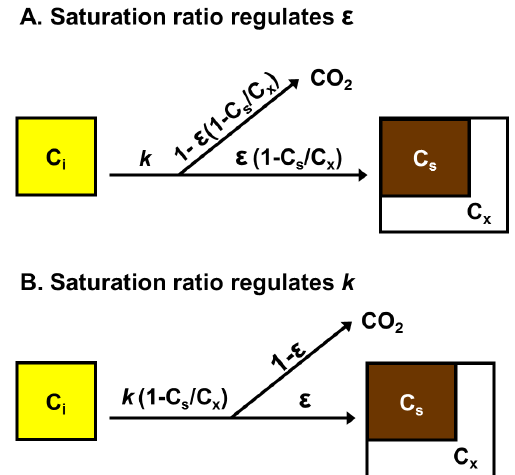
Figure 1. Conceptual models illustrating two different methods of implementing C saturation dynamics. In both models, the C satura- tion ratio of the saturating pool is defined by the ratio of the current pool size (C s ) to a theoretical maximum pool size (C x ) , or C s /C x . In model A, the C saturation ratio regulates the C transfer efficiency ( ε) between the donor pool (C i ) and C s . As the C saturation ratio increases, less of the C decomposed from C i is transferred to C s , and more is respired as CO 2 . In model B, the C saturation ratio reg- ulates the decomposition rate ( k) of C i , such that the rate decreases as the C saturation ratio increases. The C transfer efficiency is not affected by the C saturation ratio in model